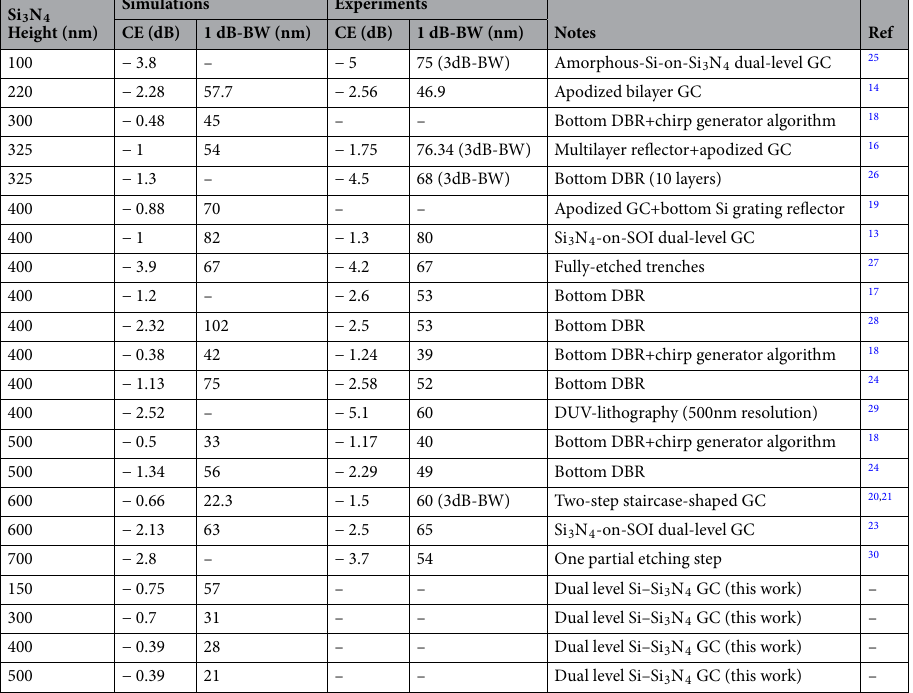
Table 1. Comparison of different GCs for the S-C-L bands demonstrated on various Si 3 N 4